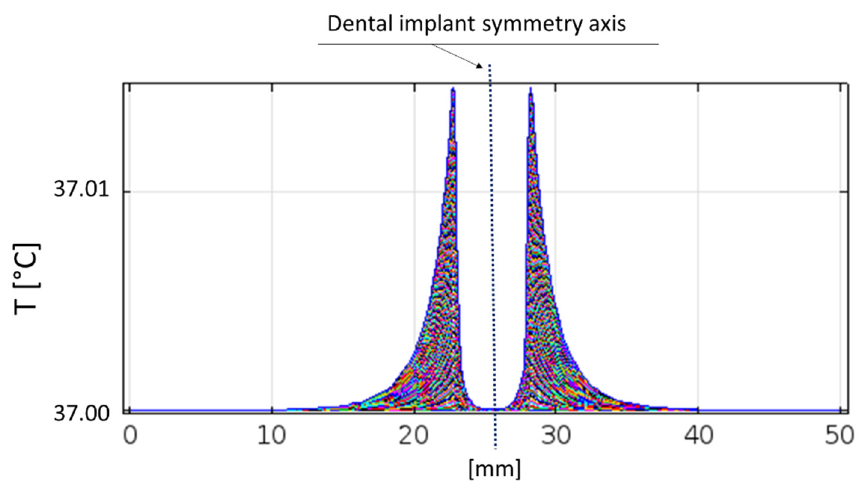
Figure 11. Temperature increase in correspondence with the horizontal line just above the implant thread (i.e., the horizontal line at a height of 12 mm in Figure 8).